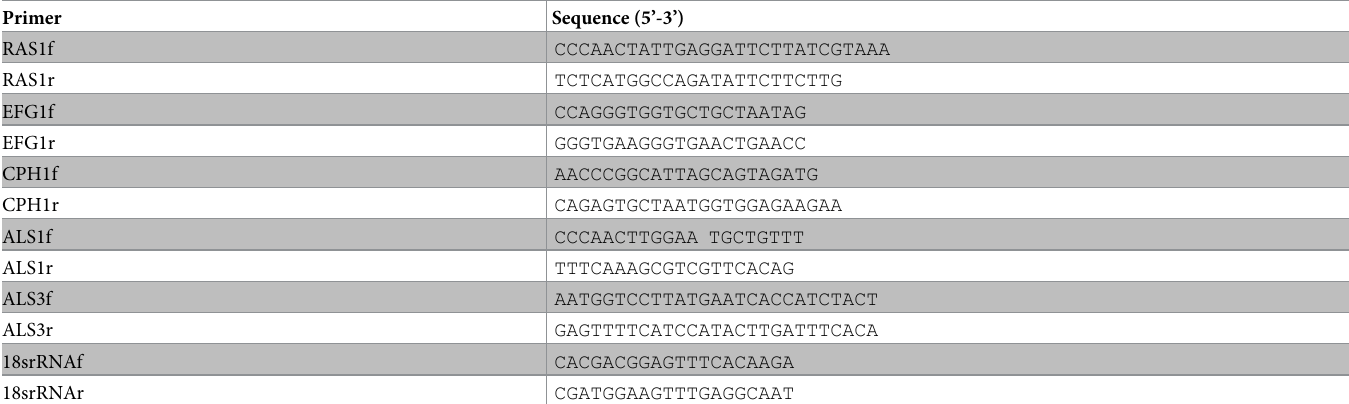
Table 1. Primers used for